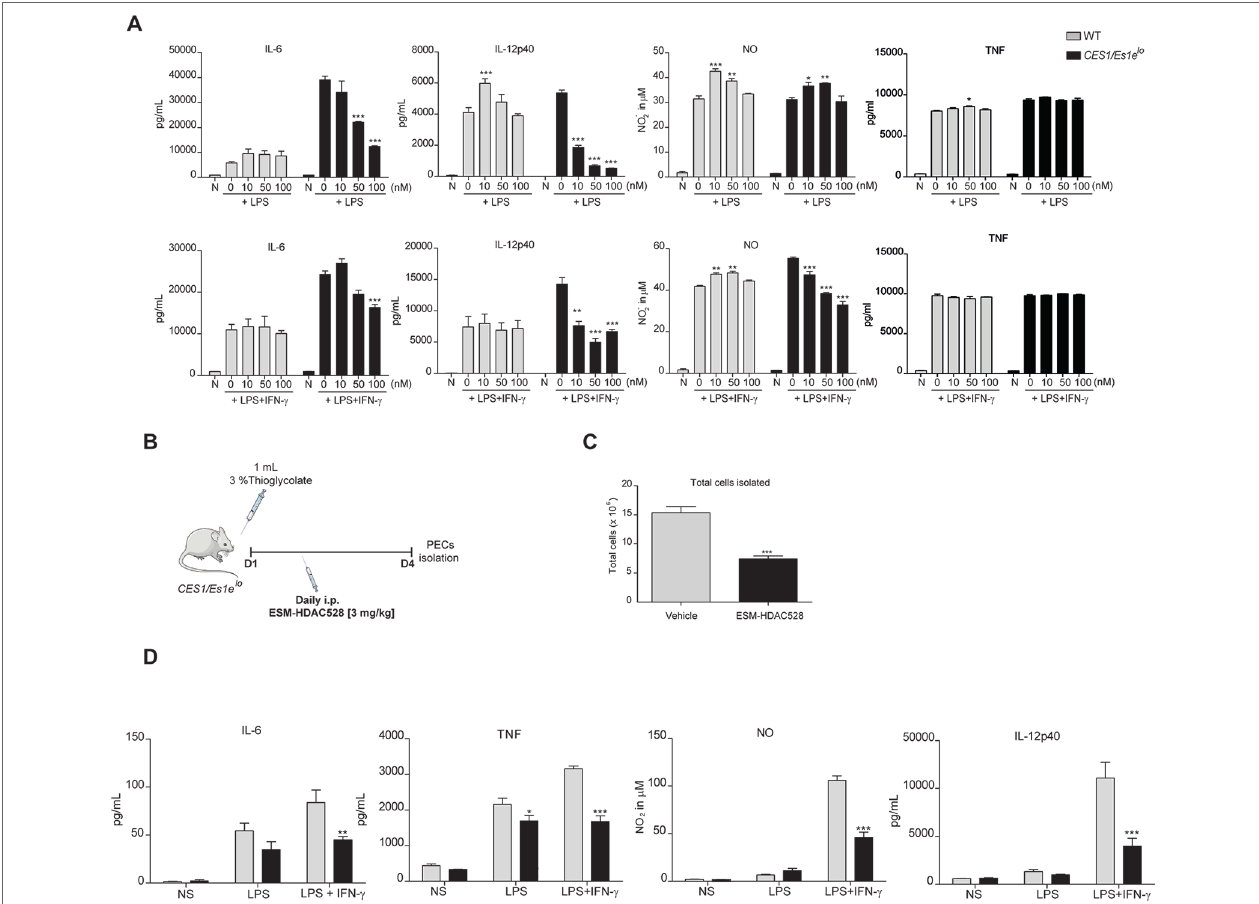
FIGURE 1 | ESM-HDAC528 reduces pro-inflammatory cytokine production both in vitro and in vivo . (A) Cytokine production by BMDMs from CES1/Es1e lo mice and WT mice after stimulation with LPS (10 ng/ml) or LPS (10 ng/ml) + IFN- γ (10 U/ml) in the presence of increasing concentrations of ESM-HDAC528 for 24 h. n = 3. (B) Design of acute thioglycolate model. Transgenic mice were treated for 4 days with daily i.p. injection of 3 mg/kg ESM-HDAC528 (n = 6) or vehicle (n = 6), on day 4, 24 h after i.p. injection PECs were isolated. (C) Total number of cells isolated from the peritoneal lavage in each group n = 6 per group. (D) Cytokine production by PEMs isolated from the mice (n = 6) of each group attached and then stimulated for 24 h with LPS (10 ng/ml) or LPS (10 ng/ml) + IFN- γ (10 U/ml). Statistical significance was determined by unpaired t -test (C) or two-way ANOVA with Bonferroni correction (A , D) (p < 0.05). All error bars represent the SEM. ns = p value > 0.05, * p value ≤ 0.05, ** p value ≤ 0.01, *** p value ≤